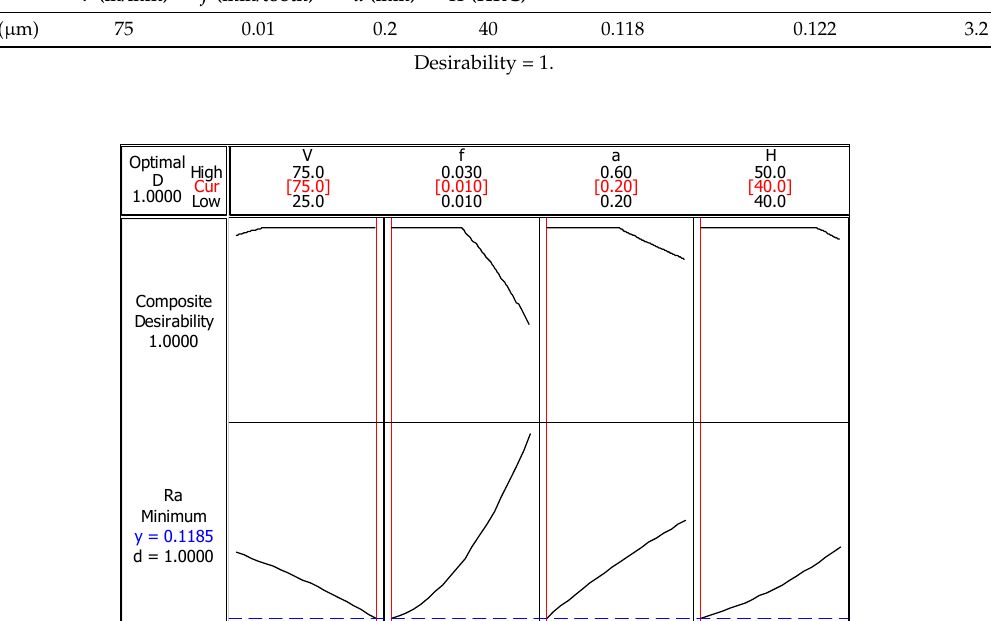
Table 7. The results of the optimization for responses.